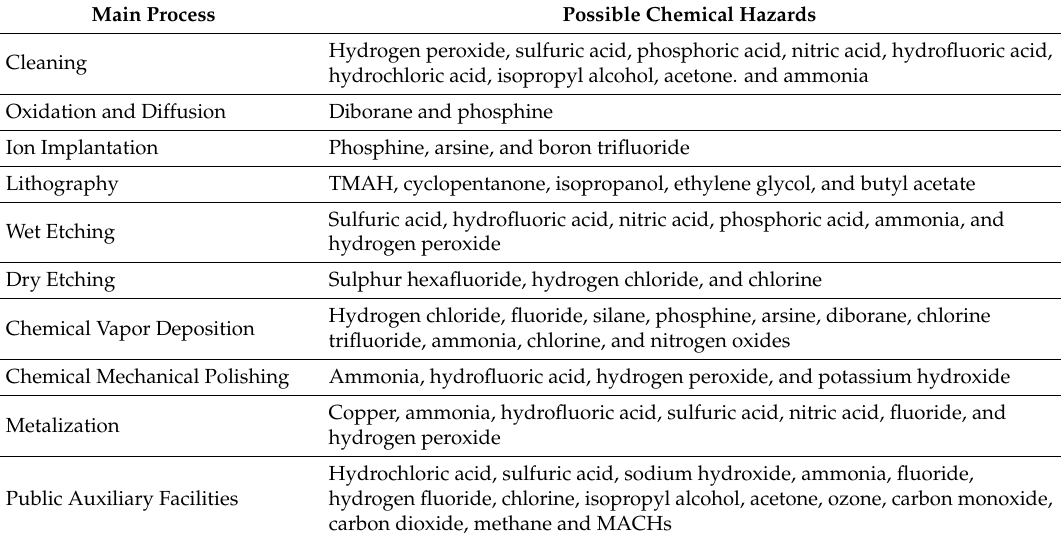
Table 1. The main technological process and occupational health hazards identification of the chip manufacturing company.